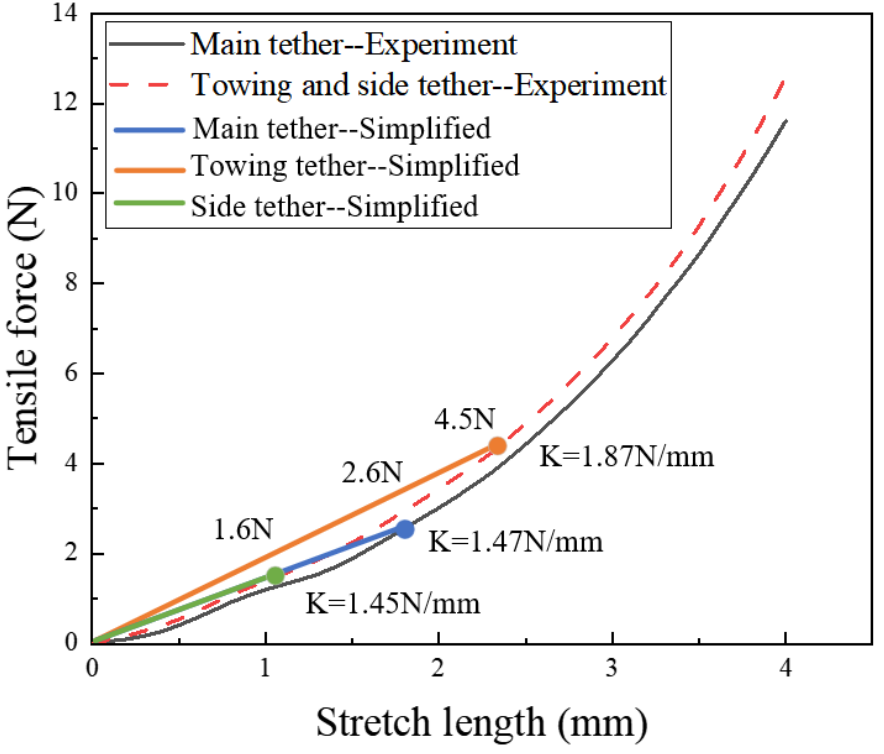
Figure 10. Result of stiffness selection. Table 2. Summary of elastic moduli of net tethers.